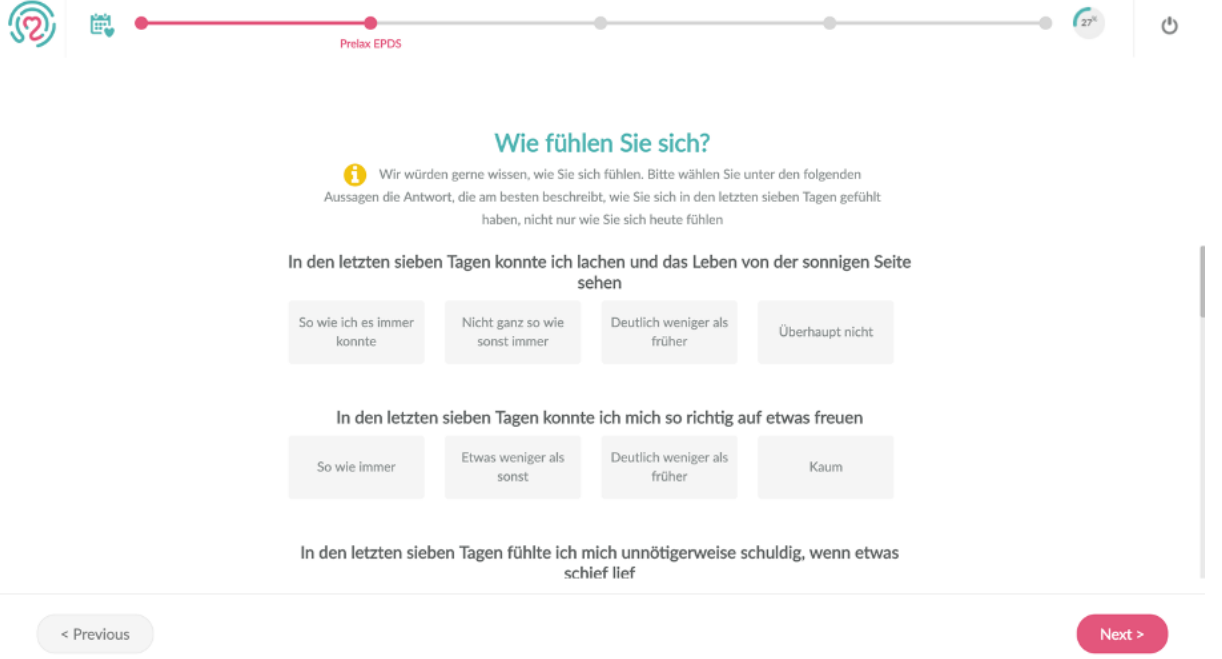
Figure 1. Screenshot of the PiiA platform. PiiA: Patient-informiert-interaktiv-Arzt (patient-informs-interactive-physician).